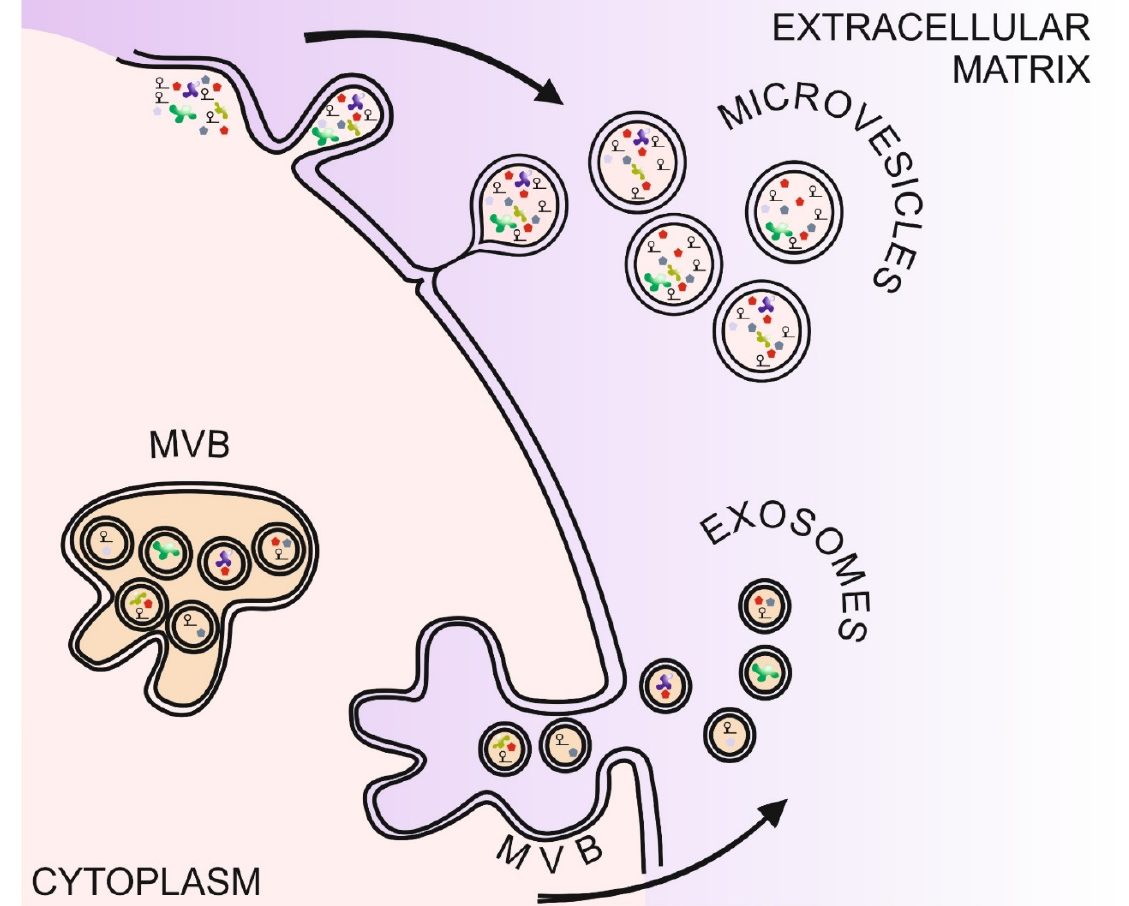
Figure 3. Schematic overview of the genesis of extracellular vesicles. The two forms of extracellular vesicles are generated via different pathways. Microvesicles are formed by budding of the cell membrane whereas exosomes are produced inside of the multivesicular bodies. These, then, can fuse with the cell membrane, releasing the exosomes into the extracellular milieu. Abbreviations used are: MVB: multivesicular bodies.